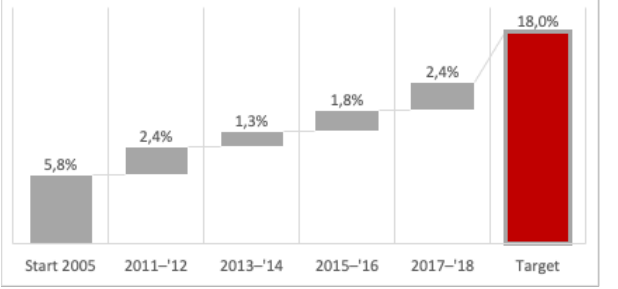
Figure 13. Germany—energy consumption trend. Source: https://ec.europa.eu/eurostat/web/ energy/data/shares, accessed on 28 June 2021.